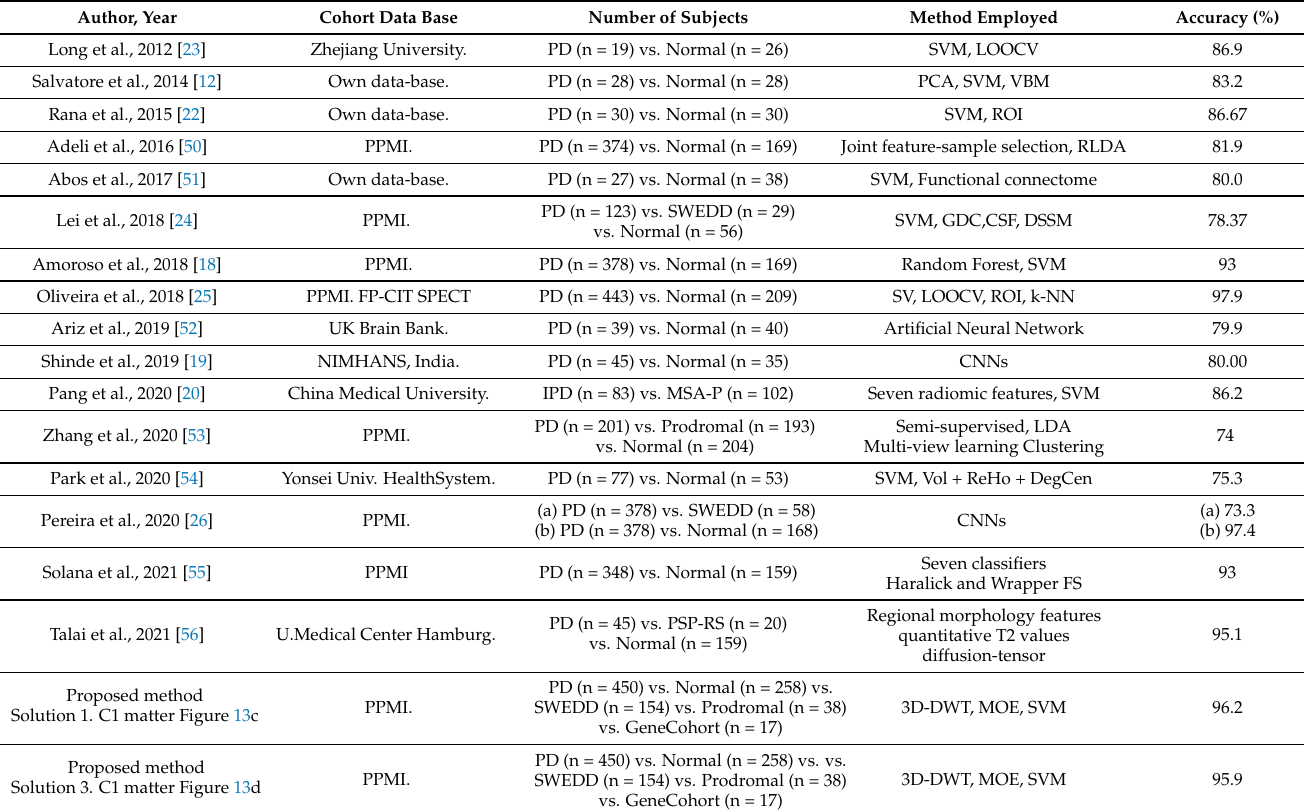
Table 7. Comparative summary of different methodologies presented in the bibliography to predict PD from MRI.